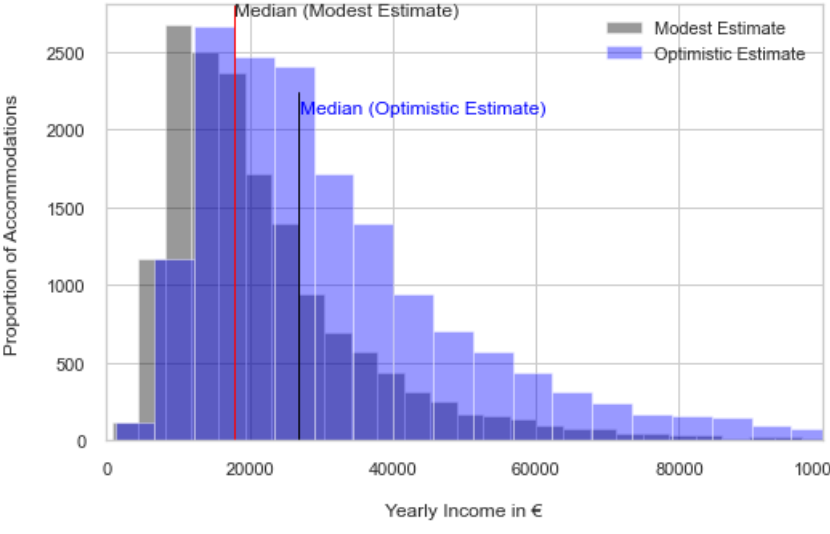
Figure 1. Average yearly